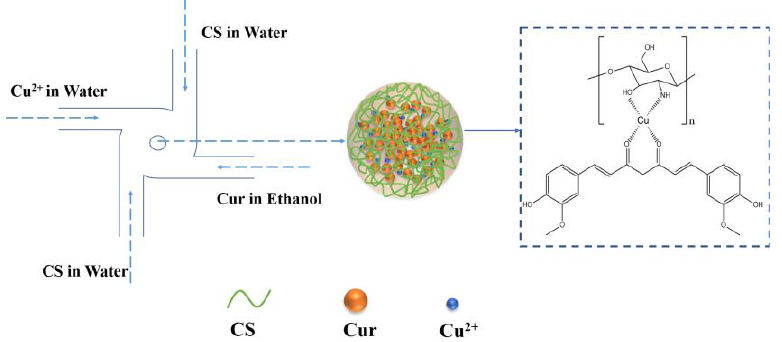
Figure 1. Schematic illustration of FNC turbulent mixing to produce a Cur-loaded CS nanocom- plex.